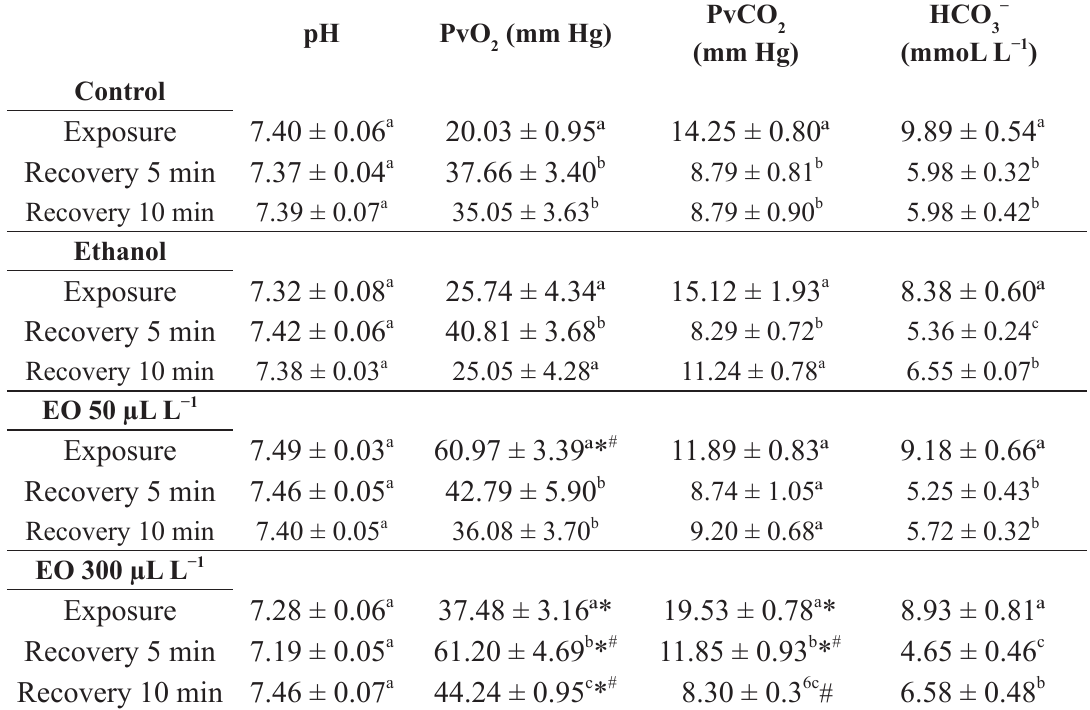
Blood parameters of Epinephelus marginatus evaluated after exposure (3.5 min) and recovery times from anesthesia induction by essential oil of Aloysia